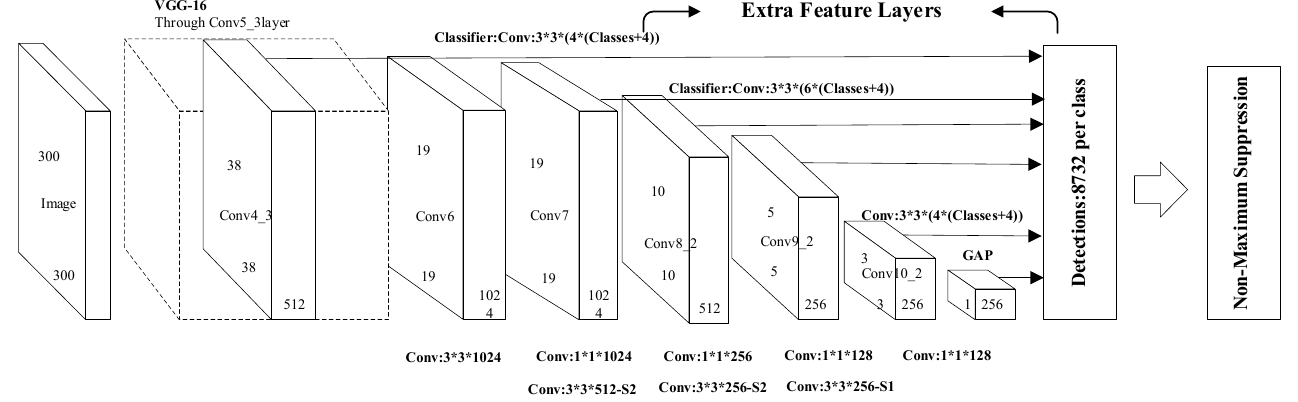
Figure 1. Basic structure of low-resolution remote sensing image recognition network.